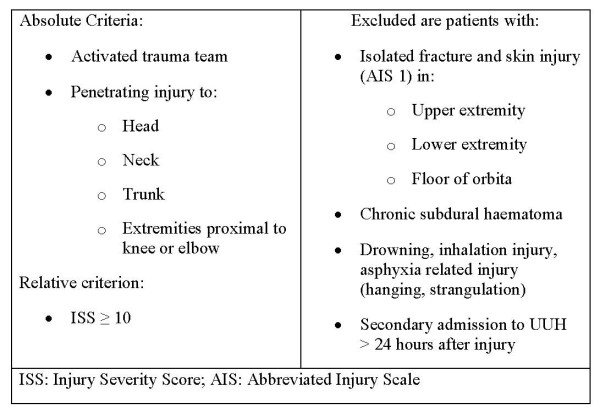
Inclusion and exclusion criteria for the UUH trauma registry.